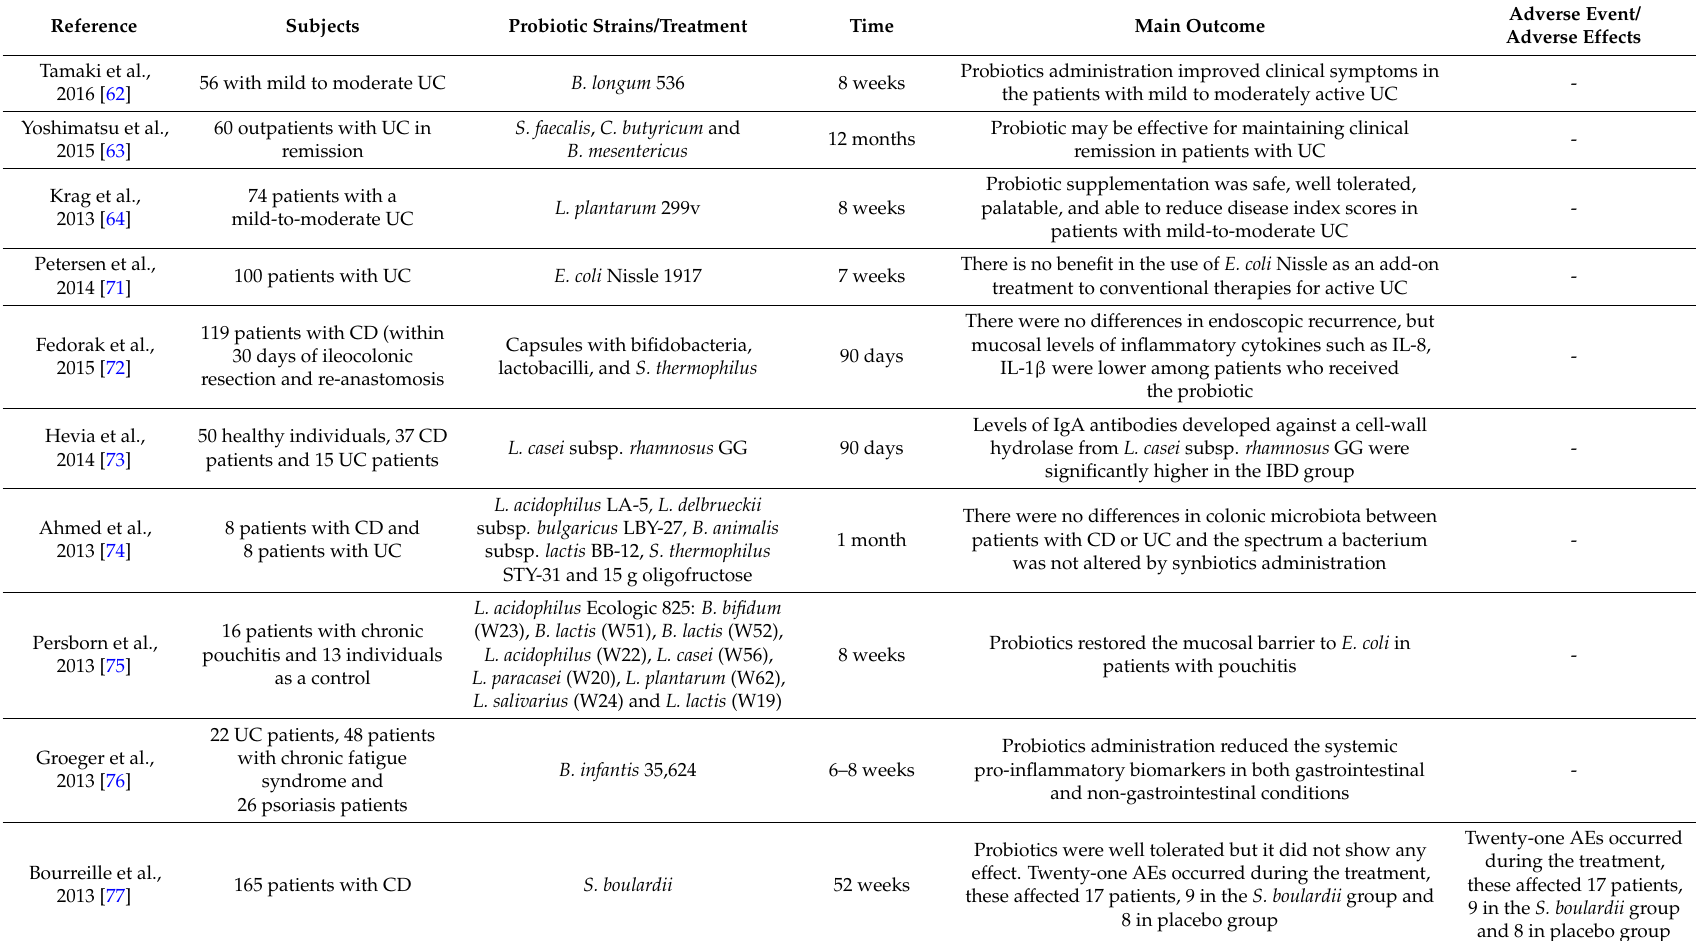
Table 3. Summary of probiotic effects on IBD in human